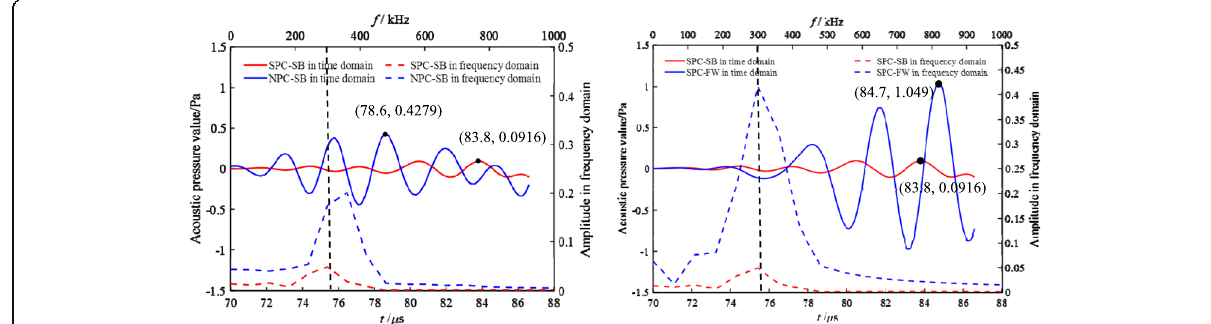
Fig. 8 The comparison of received direct signal of ultrasound waves from time domain and frequency domain: a SPC-SB and NPC-SB and b SPC-SB and